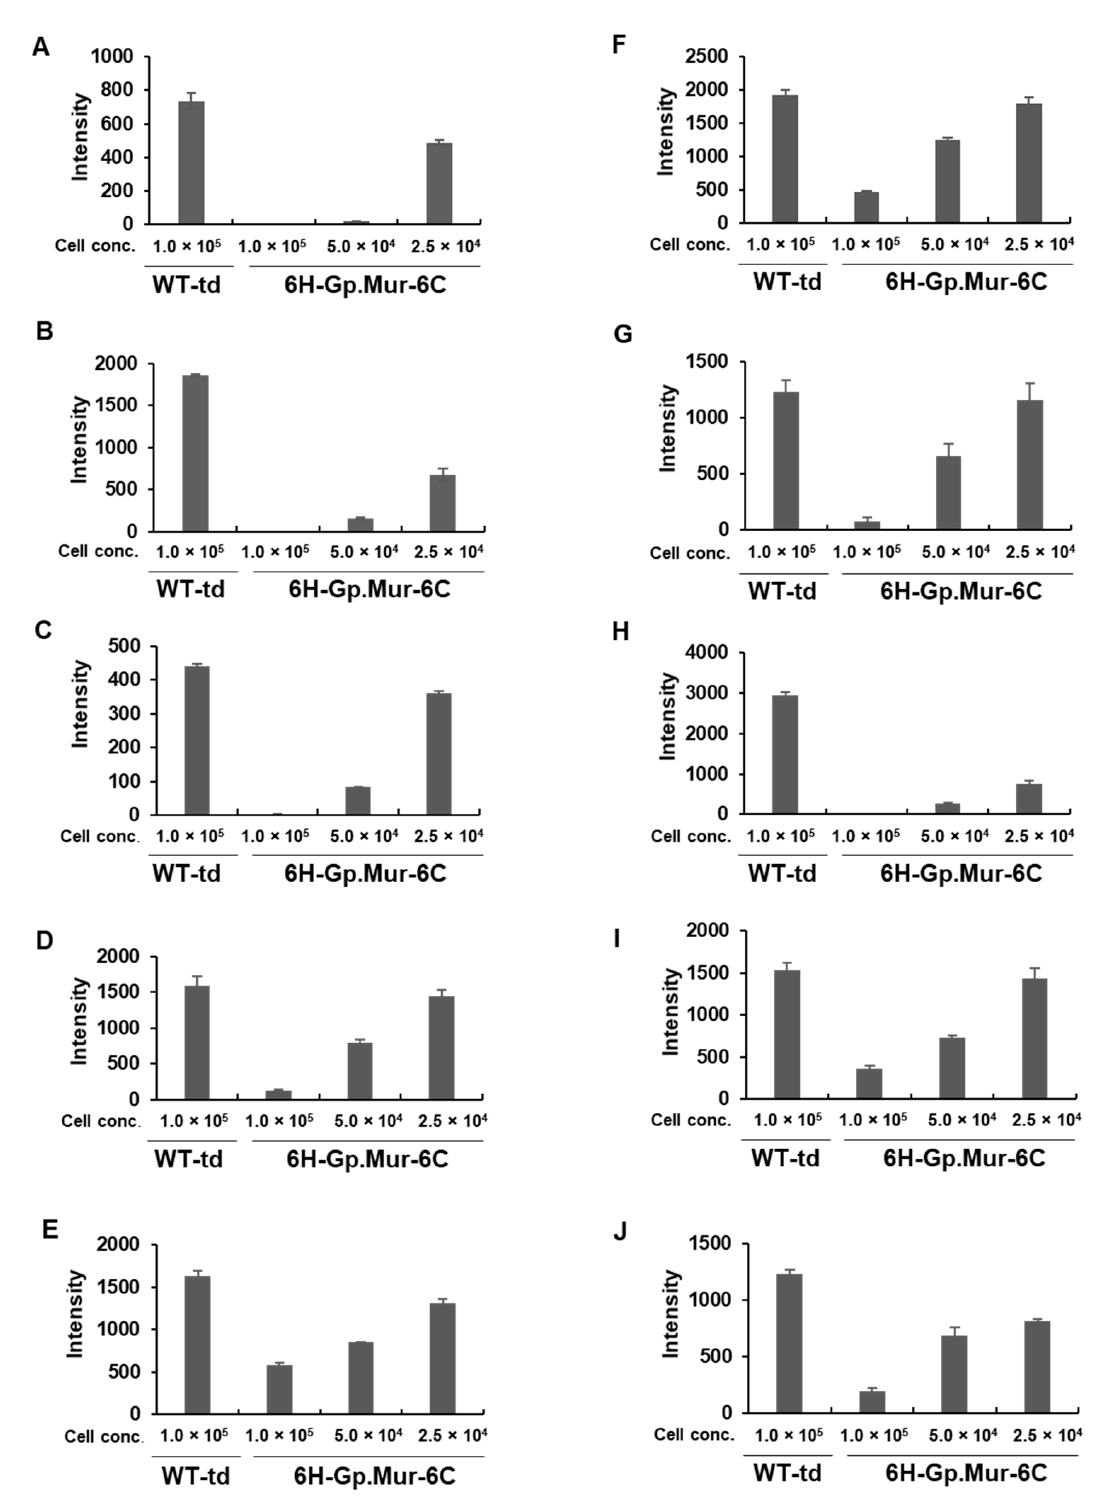
Figure 4. Quantification of hemagglutination by means of densitometry. Samples ( A – J ) were subjected to densitometric analysis. After grading the hemagglutination in samples according to the conventional tube method, the RBC agglutinates were carefully loaded onto 96-well plates and subjected to densitometric analysis. Letters correspond to the same samples used for the conventional tube method (Figure 3). X axis reflects the cell concentrations (cell conc.) of the adsorbing cells (WT-td and 6H-Gp.Mur-6C), while the Y axis reflects the signal intensity as measured by the densitometric analysis.